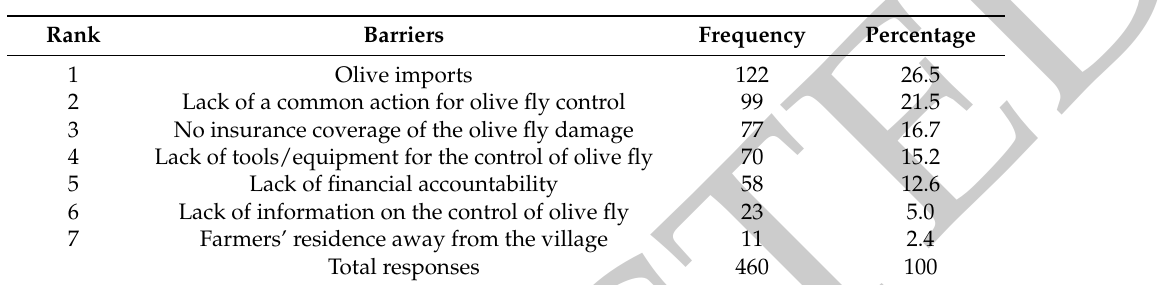
Table 6. Perceived barriers for IPM adoption among olive